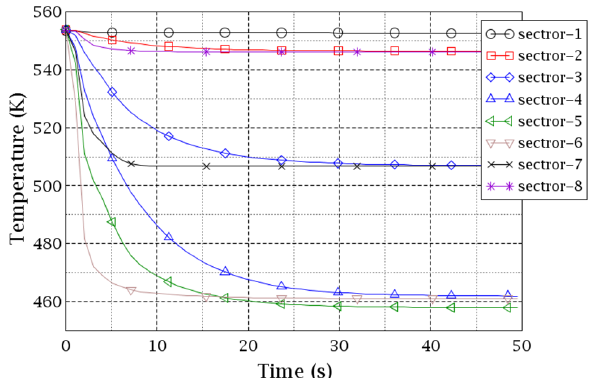
Figure 19. Evolution of the coolant temperature distribution at the core inlet of the AP1000 reactor CY-V (cell index is from Figure 17).